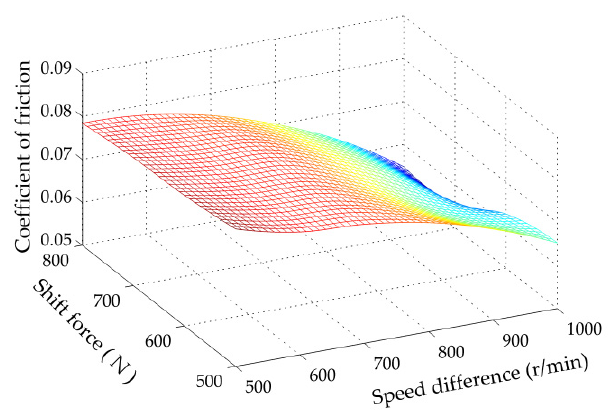
Figure 6. MAP diagram of friction coefficient after bicubic interpolation.